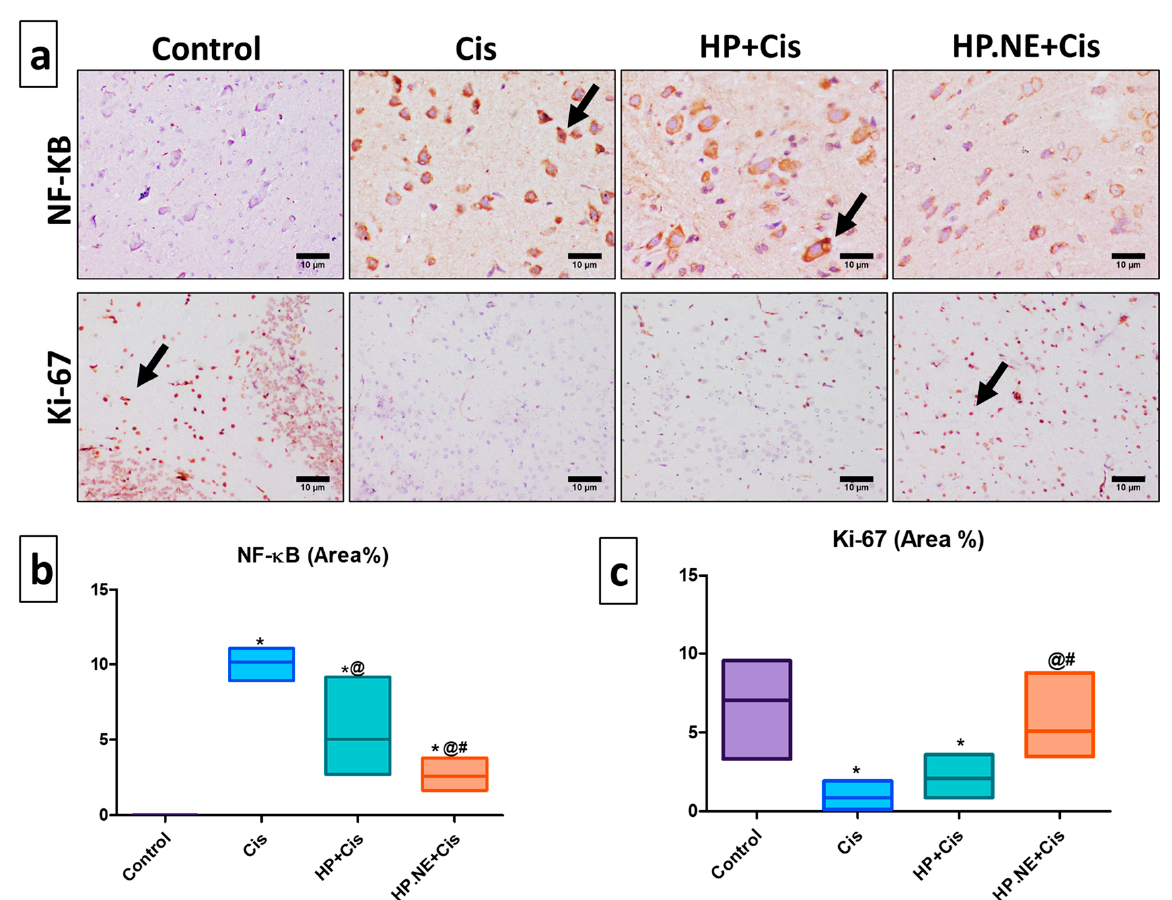
Figure 8. Immunohistochemical staining of inflammatory Nuclear factor kappa B (NF- K B) and proliferative (Ki-67) markers in brain tissues of all groups. ( a ) Photomicrograph of brain tissues stained with NF- K B and Ki-67 (H&E); scale bars denote 10 µ m. Remarkable arrows on the figure point to strong positive staining. ( b ) Statistical analysis of NF- K B expression (area%). ( c ) Statistical analysis of Ki-67 expression (area%). * means significant from the control group; @, significant from the Cis group; and #, significant from HP + Cis group.